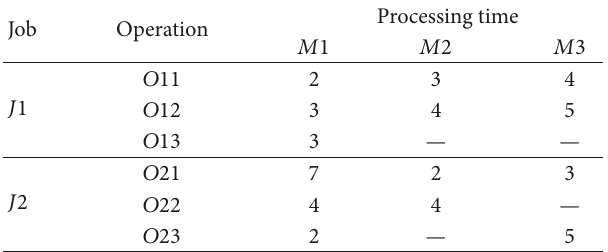
Table 1: Processing information of FJSP with 2 jobs and 2